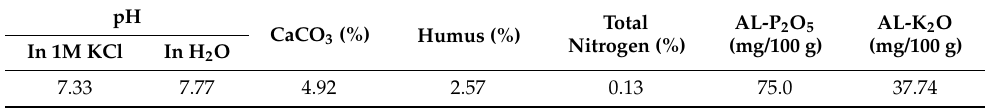
Table 1. Basic chemical characteristics of the